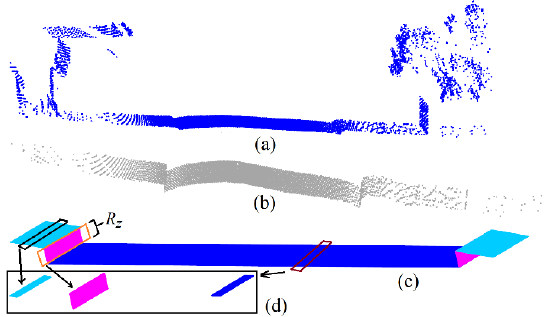
Figure 2. Illustration of stripe and patch; (a) an individual stripe of a road point cloud, (b) extracted ground surface, (c) sketch of road surface, and (d) three different patches corresponding to sideway, curb and pavement